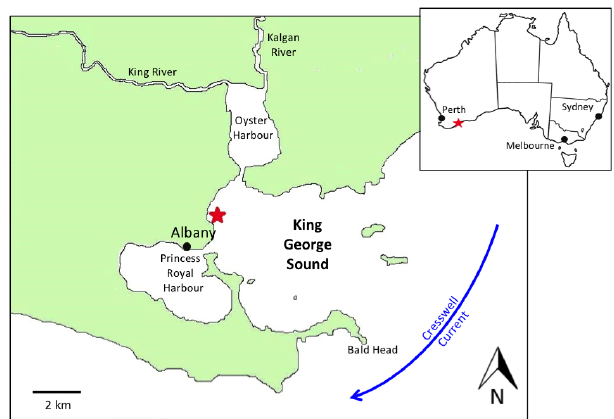
Figure 1. A map of King George Sound and the surrounding coast- line in south Western Australia. The sampling site is indicated by the red star.